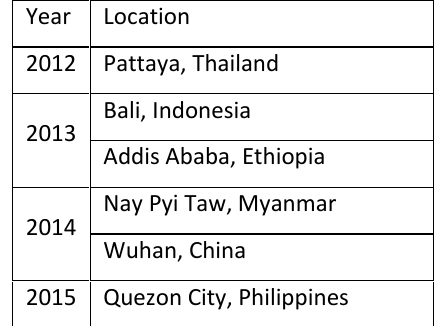
Figure 1. Membership density map.